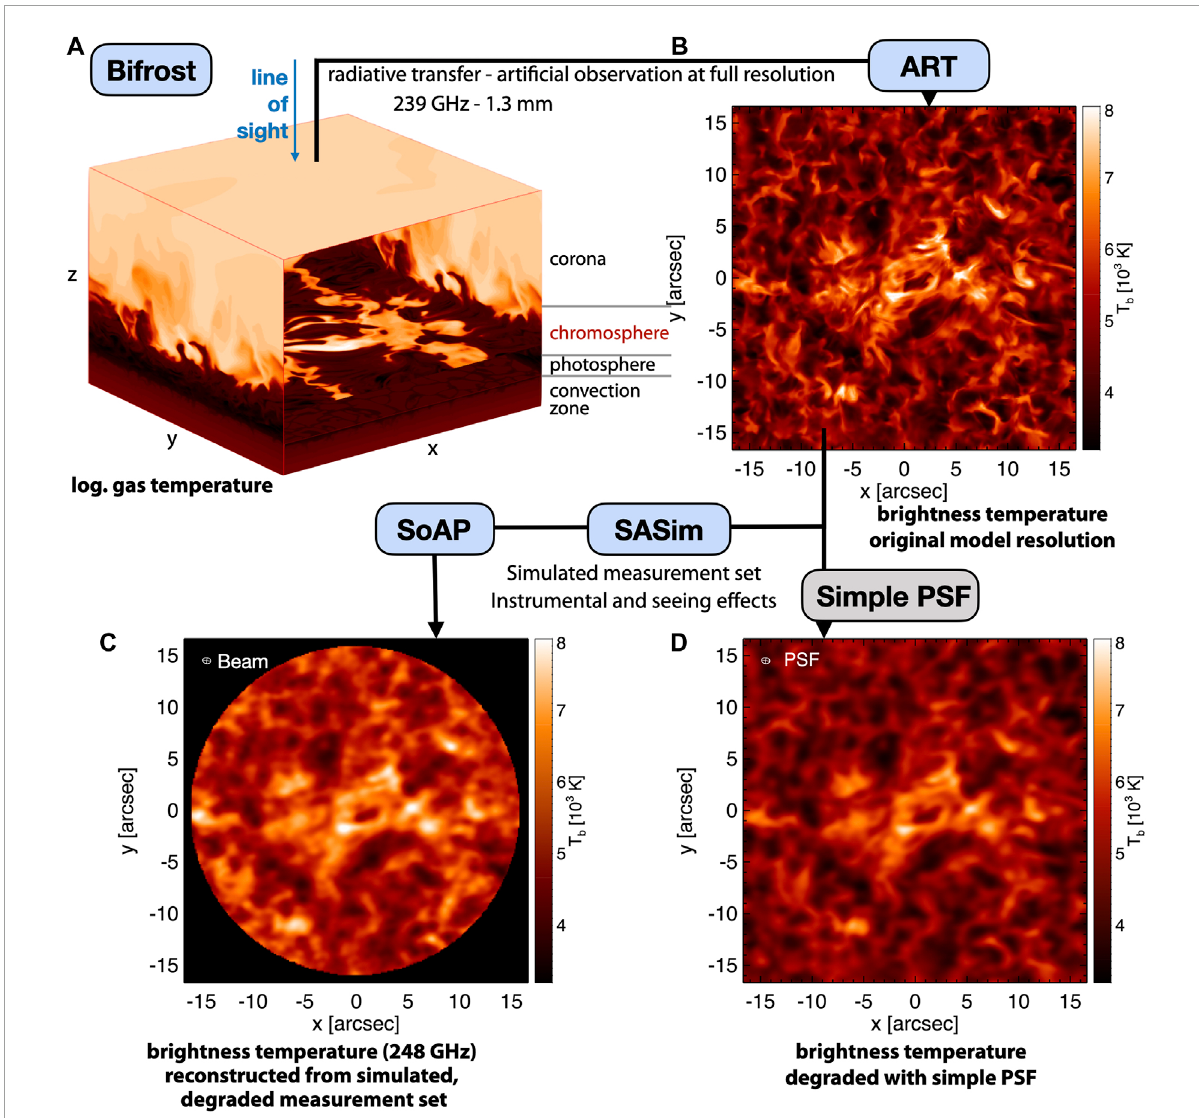
FIGURE 1 Forward modeling of synthetic brightness temperatures at millimeter wavelengths starting with a 3D model snapshot (or a time series of such) from a Bifrost simulation (A) . The model features an enhanced network region in the center surrounded by quiet Sun. The radiative transfer calculations with ART produce a brightness temperature map for the selected frequencies [shown here: 239 GHz, (B) ] to which then a simple point spread function (PSF) equivalent to an idealized synthesized beam for ALMA can be applied (C) . The PSF is shown in the top left corner of the panel. A more realistic simulation of atmospheric seeing and instrumental effects as performed using SASim (and then reconstructed using SoAP) results in stronger degradation (D) of the original image than the simple PSF. It is to be noted that only a moderate example is shown that corresponds to good observing conditions. The synthesized beam is shown in the corner of the reconstructed image in panel (D)